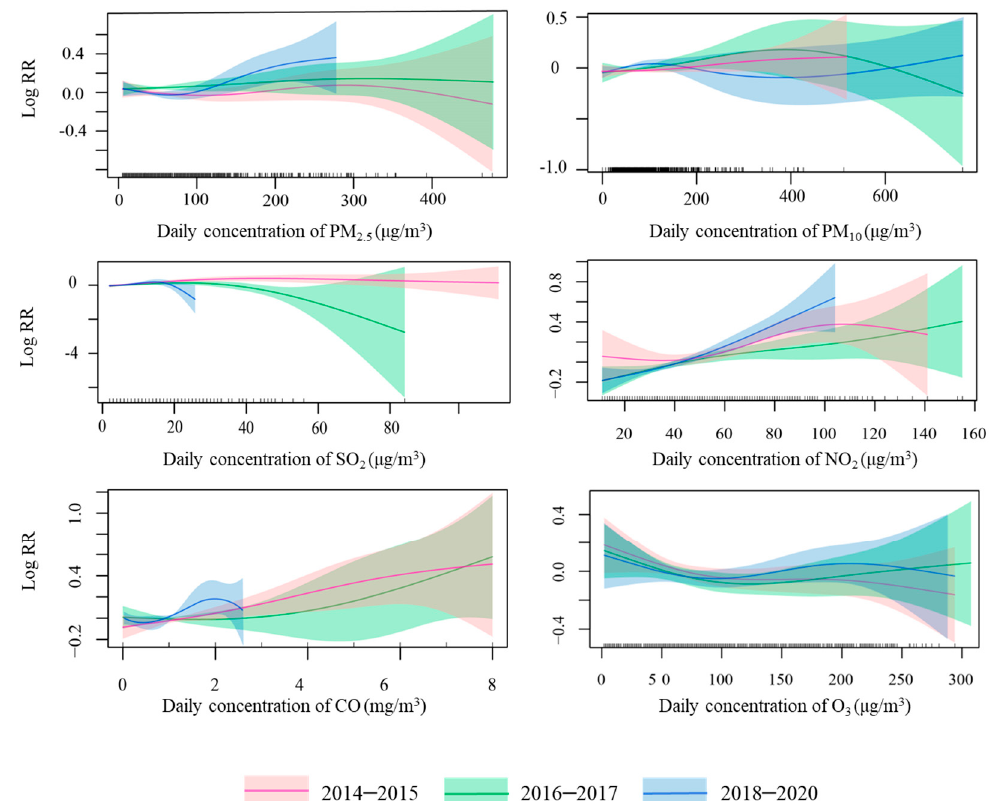
Figure 4. The concentration-response relationship curves of air pollutants versus AR visits for specific periods. Note: The X -axis represents the moving average concentration at lag0. The Y -axis represents the log relative risk (RR). The lines show the mean estimates, and the ribbons show the 95% confidence intervals.